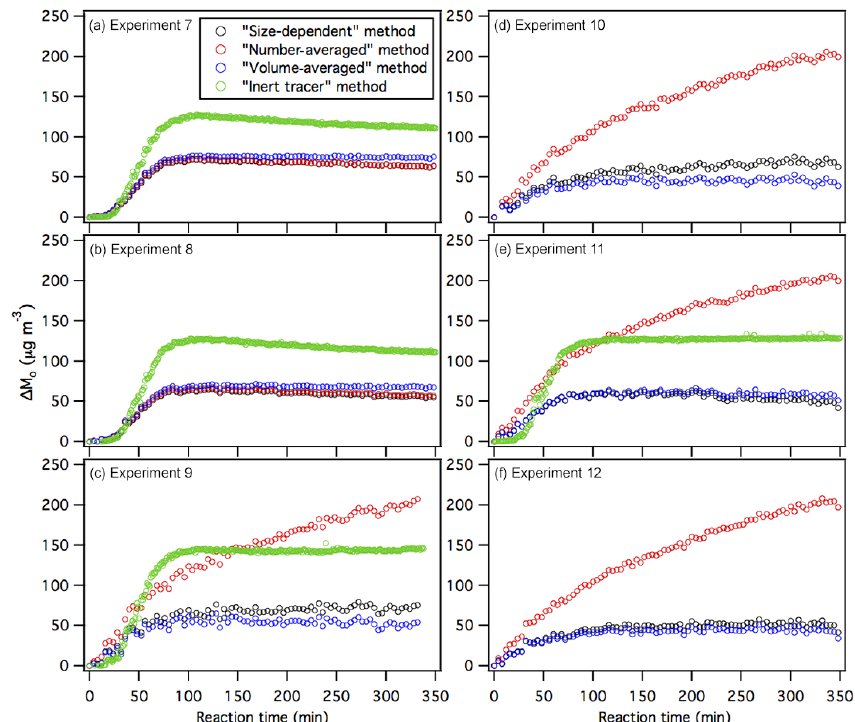
Figure 5. SOA mass concentration ( (cid:49)M o ) as a function of reaction time in the α -pinene ozonolysis experiments using the size-dependent, number-averaged, volume-averaged and inert tracer particle-wall deposition correction methods. HR-ToF-AMS data were not available in experiments 10 and 12; therefore, SOA mass concentrations calculated using the inert tracer method were not available in these